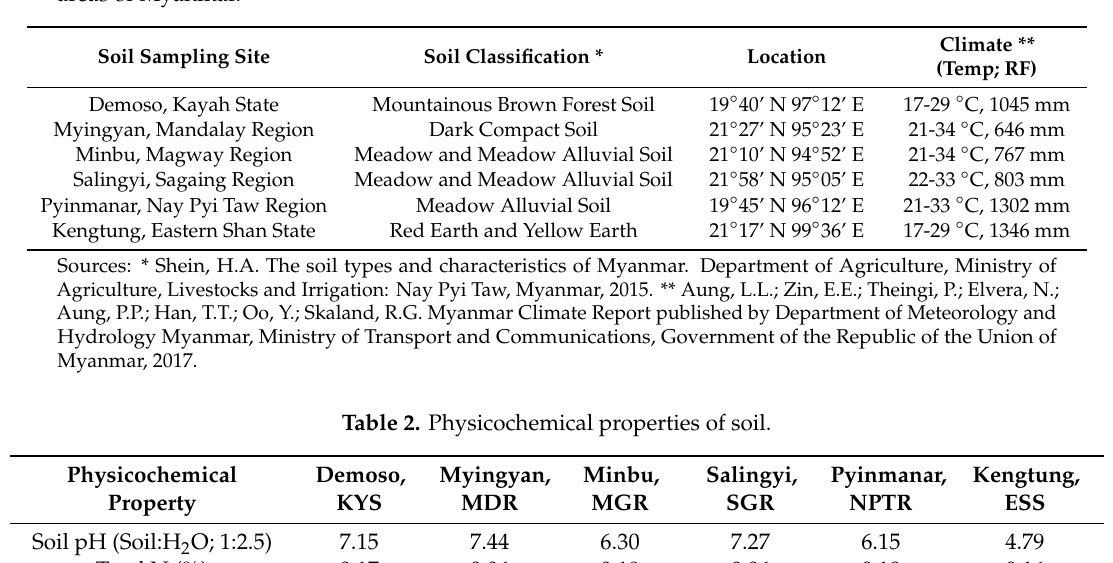
Table 1. Soil classification, location and climate of soil samples collected from major chickpea growing areas of Myanmar.